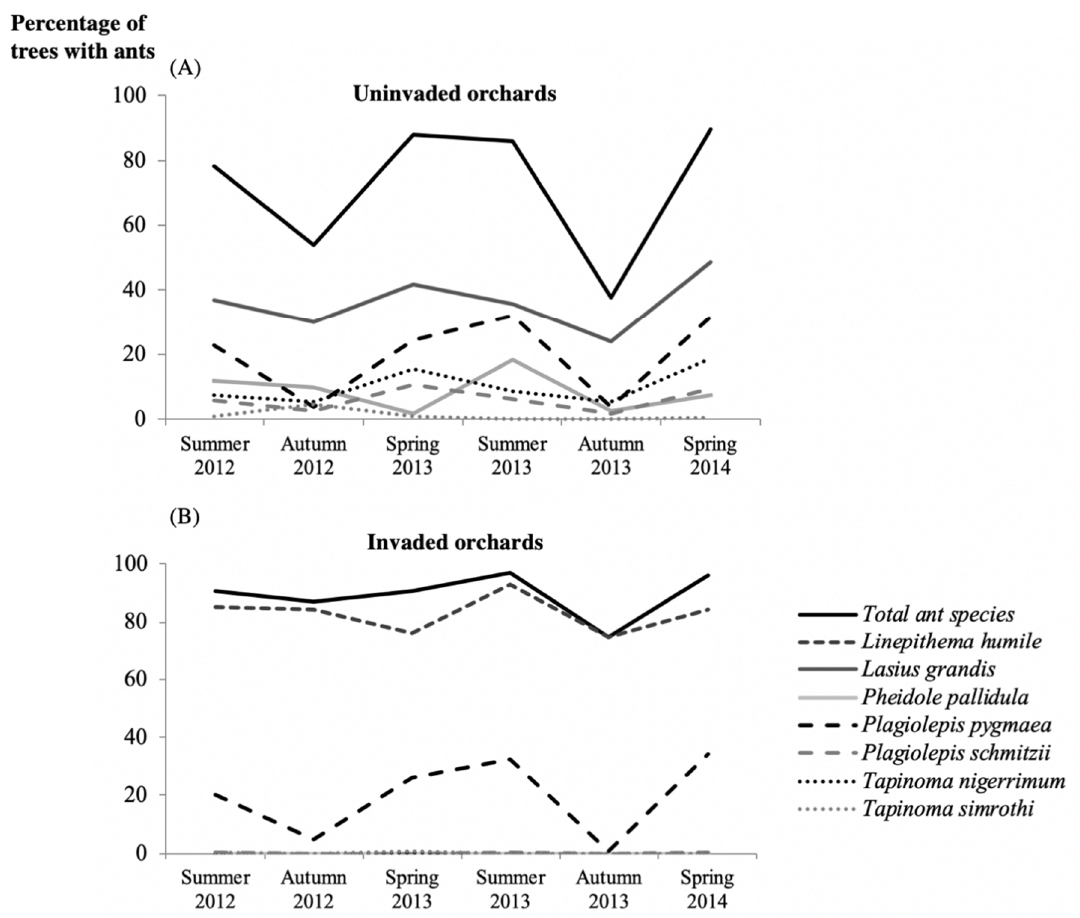
Figure 4. Seasonal variation in the percentage of trees with the most frequent ant species by season in the uninvaded ( A ) and invaded orchards ( B ). In each season, 240 trees were observed by modality.